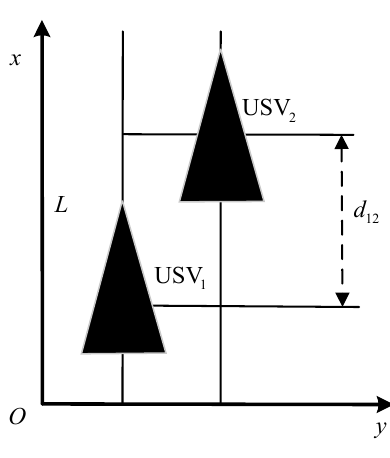
Figure 3. Description of USV formation